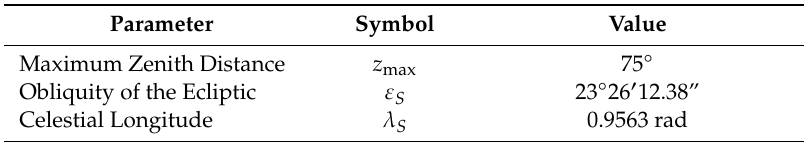
Table 2. Sun parameters.